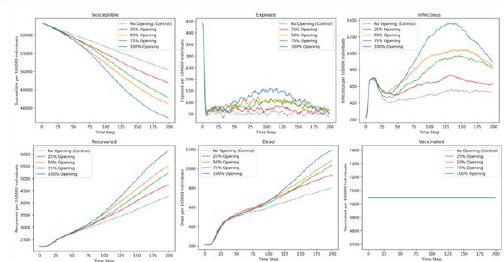
Figure 9. COVID-19 Temporal Dynamics for Quezon City,